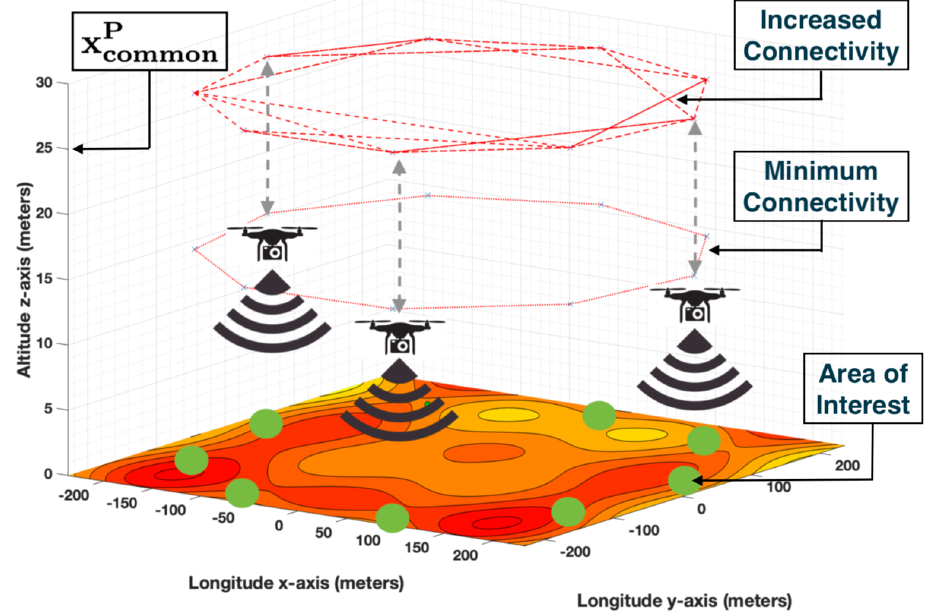
Figure 1. Overview of the experimental